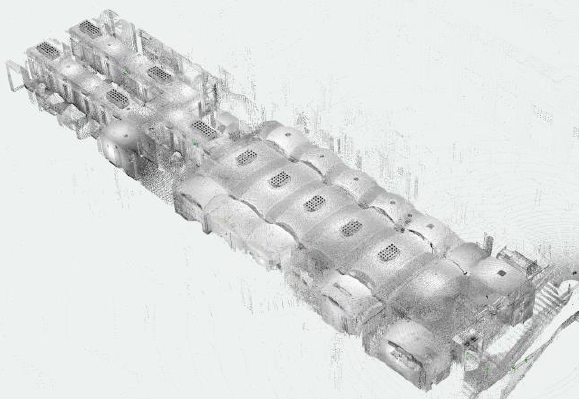
Figure 17. Case Study 2: Scan location computed with the target- based method using Faro Scene software. Scans are overlaid over am existing plan of the Albergo Diurno di Porta Venezia.